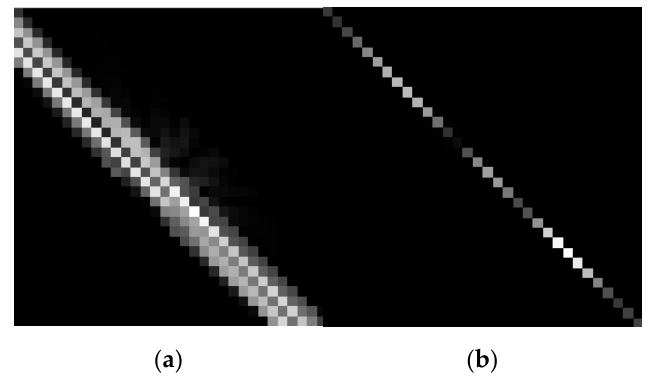
Figure 5. Channel frequency matrix ( H (cid:2914)(cid:2916) ) of PFFT ( a ) and PFrFT ( b ).